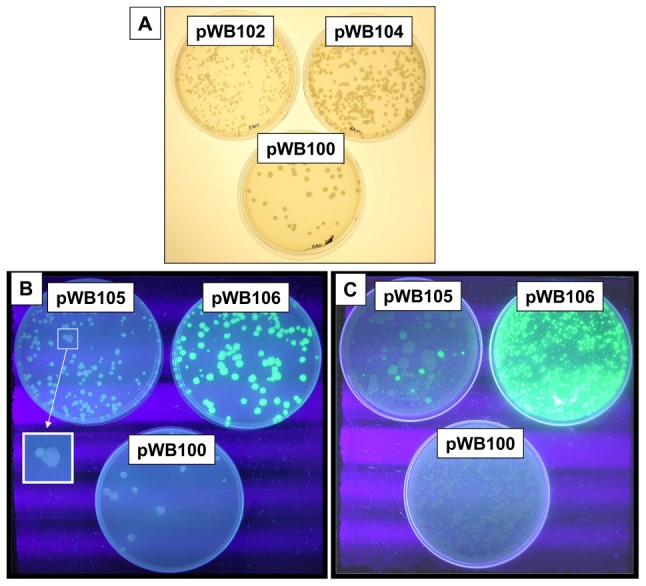
Colony size and expression of GFP by recombinant mycobacteria grown on solid medium.
A. Colonies of M. smegmatis transformed with pWB102, pWB104 and pWB100 viewed under normal light. B. Colonies of M. smegmatis transformed with pWB100, pWB105 or pWB106 viewed over UV light. The insert shows a magnified view of a mutant, non-expressing clone adjacent to a normal clone. C. Colonies of M. bovis BCG transformed with either pWB100, pWB105 or pWB106 viewed over UV light.